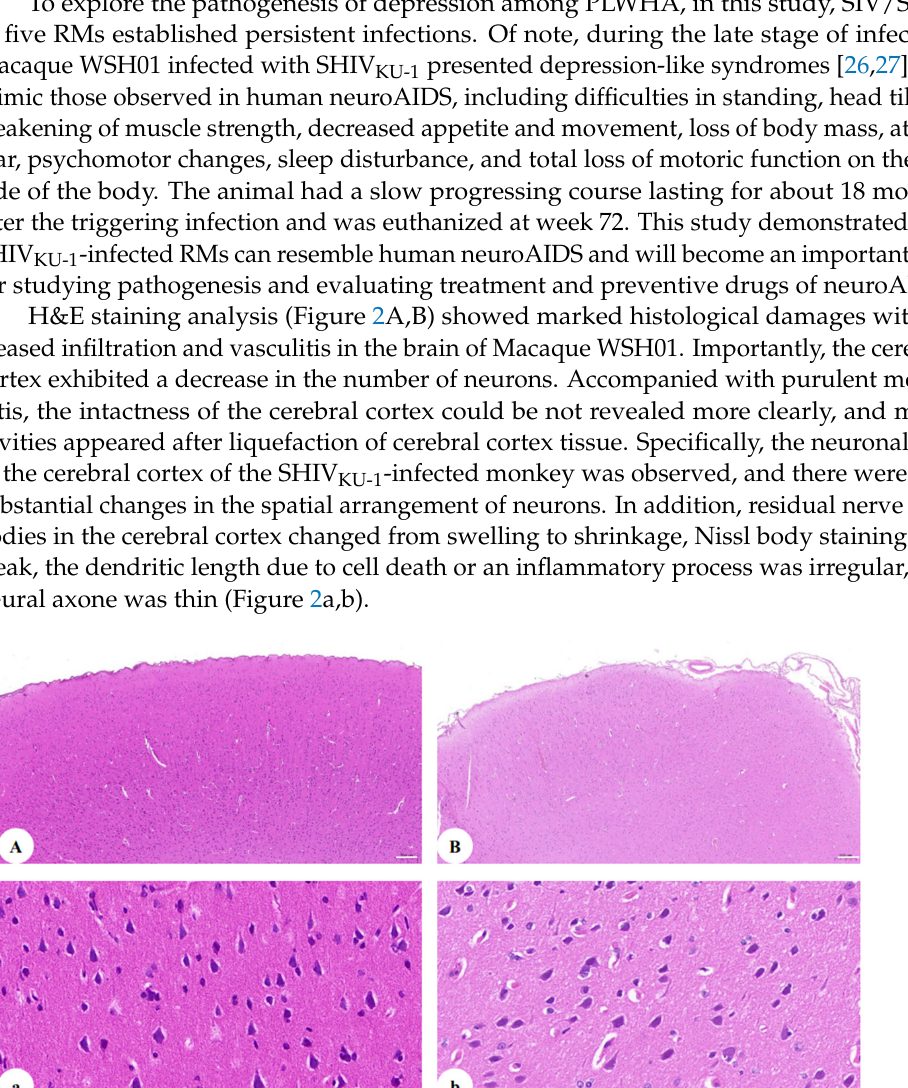
Figure 3. NUCB1 protein expression in cerebral cortex: (( A ) the healthy control (400×); ( B ) SHIV KU- 1 -infected monkey (400×) ( C ) comparison of NUCB1 expression of cerebral cortex in healthy control and SHIV KU-1 -infected monkey using Western blotting. In the column, from the t test, statistically significant differences of the two groups can be determined ( p = 0.0056). ** p < 0.01. 3.6. Down-Regulation of CNR1 Protein in Cerebral Cortex of SHIV KU-1 -Infected Monkey Finally, 16 potential targets relative to depression were acquired from the TCMSP database (https://old.tcmsp-e.com/disease.php?qd=228, accessed on 19 March 2022) and further analyzed by the online STRING database (http://string.embl.de/, accessed on 15 March 2022) to explore the functional mechanism of the NUCB1 protein.